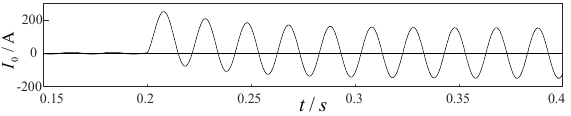
Figure 8. Waveform of zero-sequence current on each line (when the fault occurs on one line).